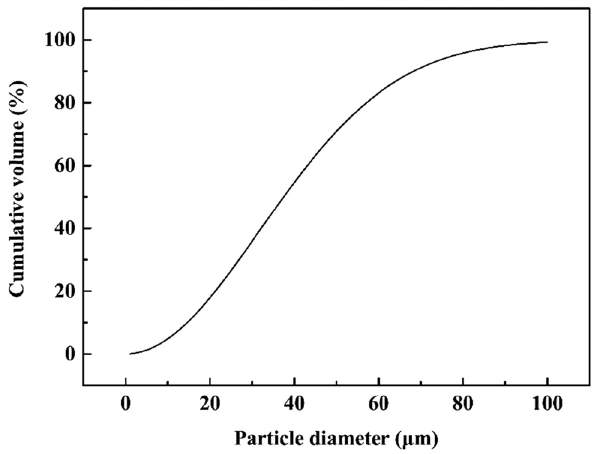
Figure 4: Particle size distribution of the pulverized